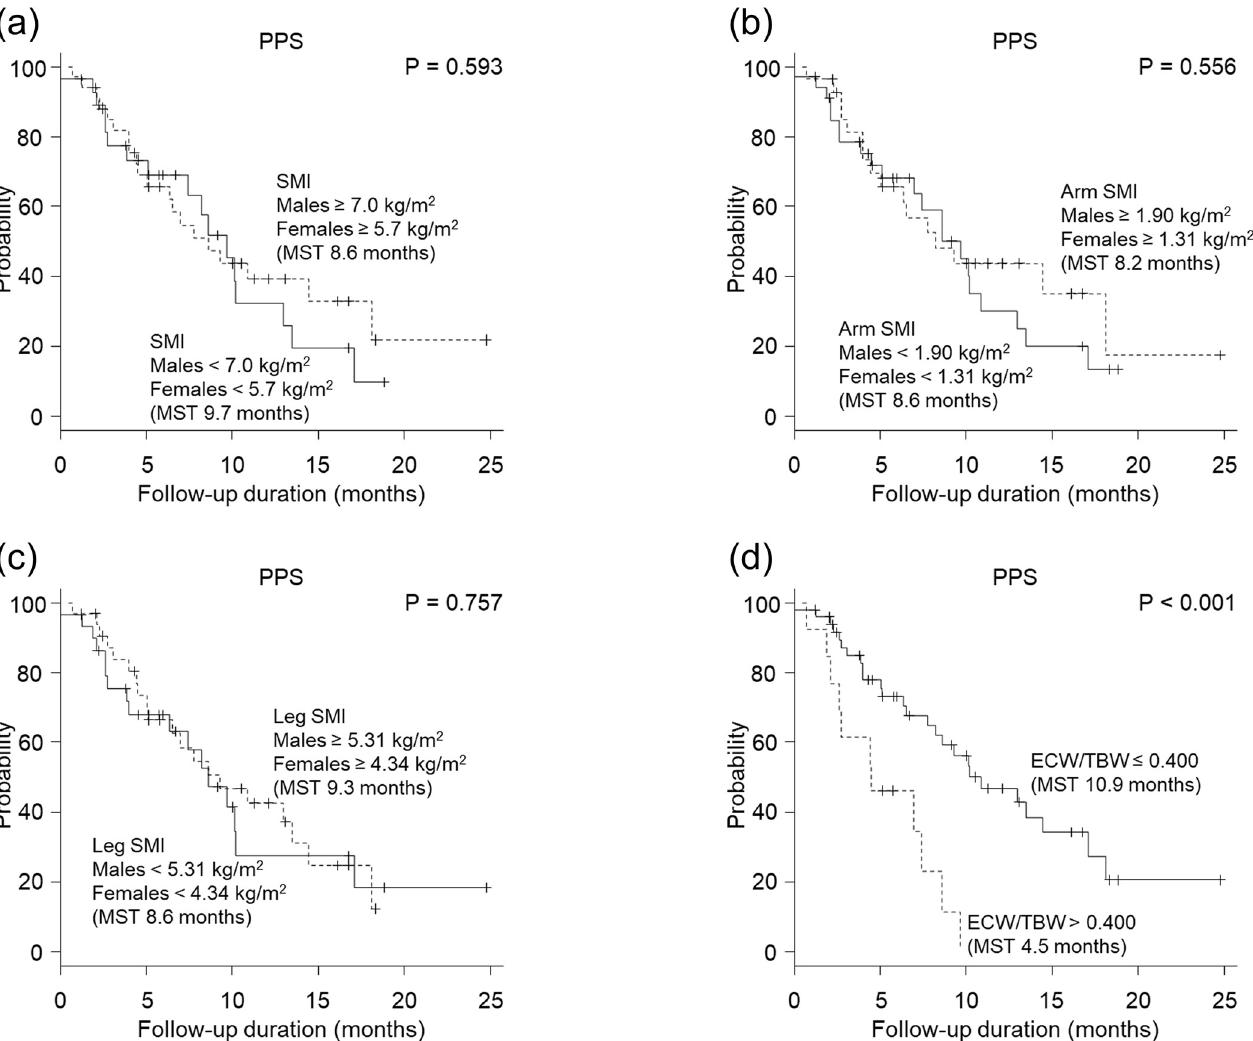
Fig 3. Association of each body composition measure with post-progression survival (PPS). (a) Total skeletal muscle mass index (SMI), (b) arm SMI, (c) leg SMI, and (d) extracellular water to total body water ratio (ECW/TBW). The cutoff for SMI was 7.0 kg/m 2 for males and 5.7 kg/m 2 for females, which aligns with the diagnostic criteria of the Japanese Society of Hepatology. The cutoff for arm SMI and leg SMI was the median value. (d) For ECW/TBW, patients with an ECW/TBW of � 0.400 experienced a significantly longer PPS than those with an ECW/TBW of > 0.400 (10.9 months vs 4.5 months, P < 0.001). (a—c) Total SMI, arm SMI, and leg SMI were not associated with PPS (total SMI, 8.6 months vs 9.7 months, P = 0.593; arm SMI, 8.2 months vs 8.6 months, P = 0.556; leg SMI, 9.3 months vs 8.6 months, P =